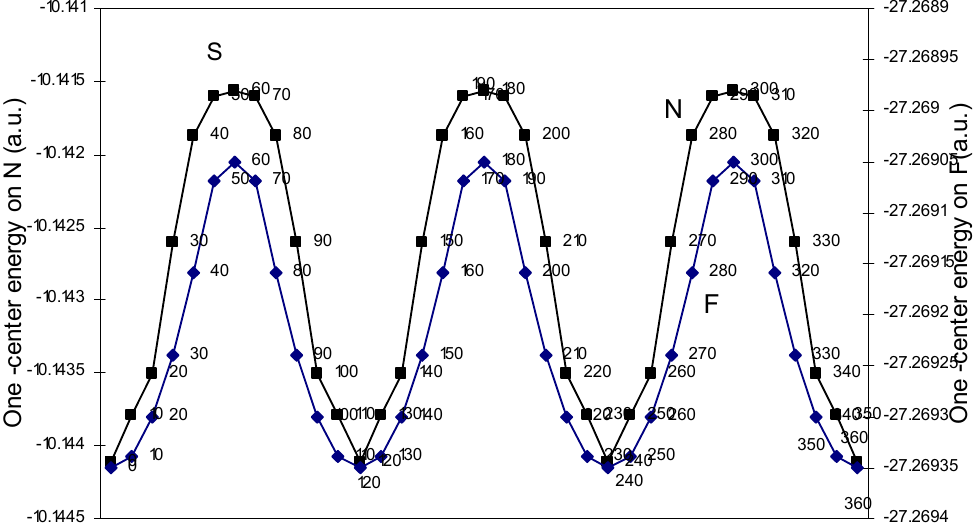
Figure 11. Plot of one-center energy (on N and F) of F torsional angle (E-Eclipsed,